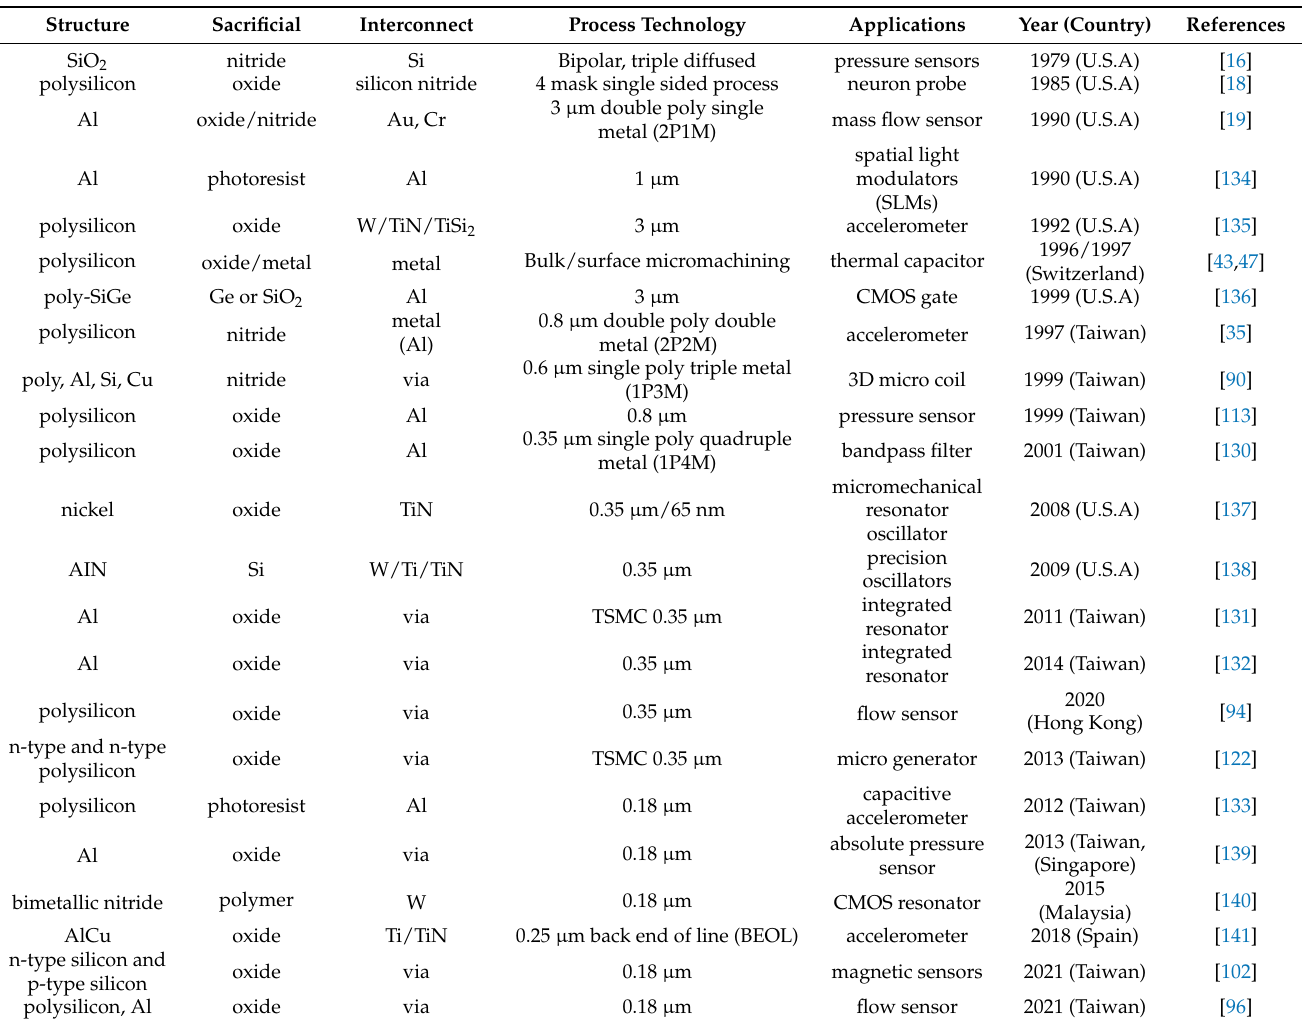
Table 1. CMOS MEMS processes technology followed in the past several